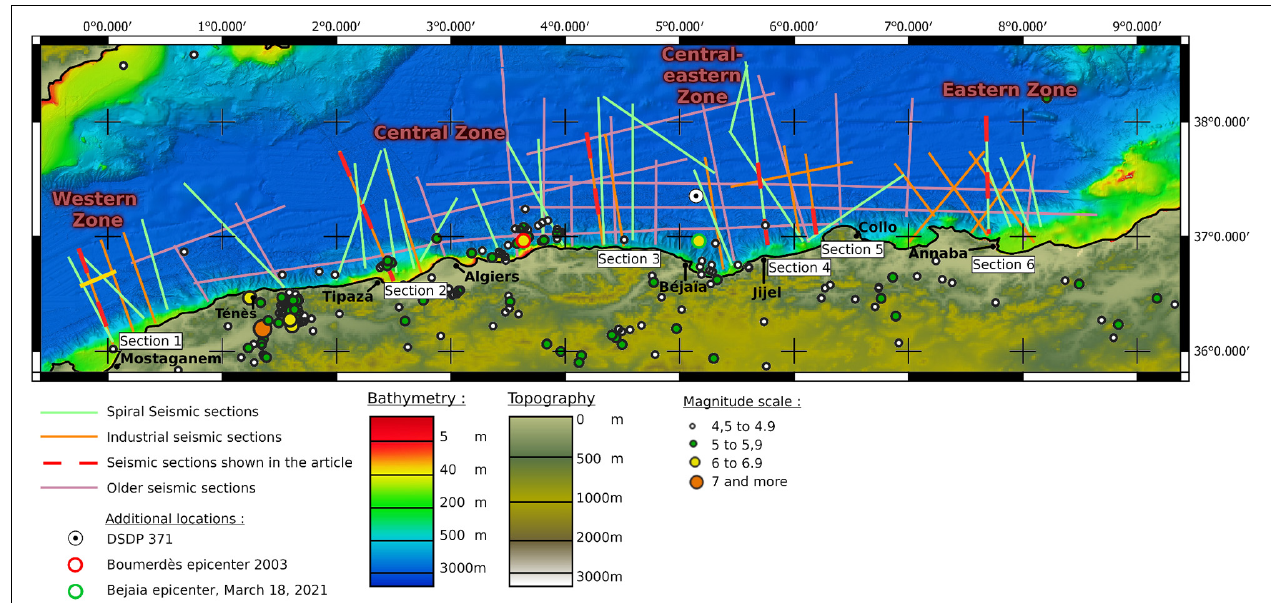
FIGURE 2 | Bathymetry and topography of the Algerian margin, along with the seismic sections which have been depth-converted. Numbered and overlined with red dashes refer to seismic sections partly displayed in this study (see Figures 4–8 ). Circles are M > 4.5 earthquakes taken from the U.S. Geological Survey